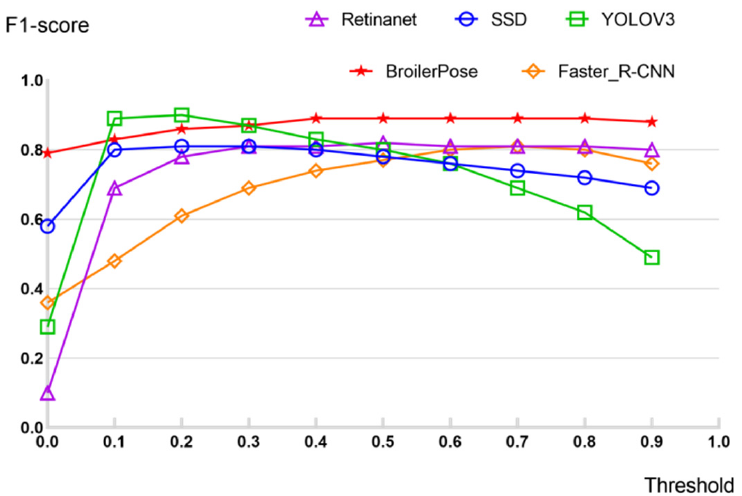
Figure 5. F 1-score for different algorithms, including BroilerPose algorithm, YOLOV3 algorithm, RetinaNet algorithm, SSD algorithm, and Faster_R-CNN algorithm. The higher the F 1-score, the better the detection effect.